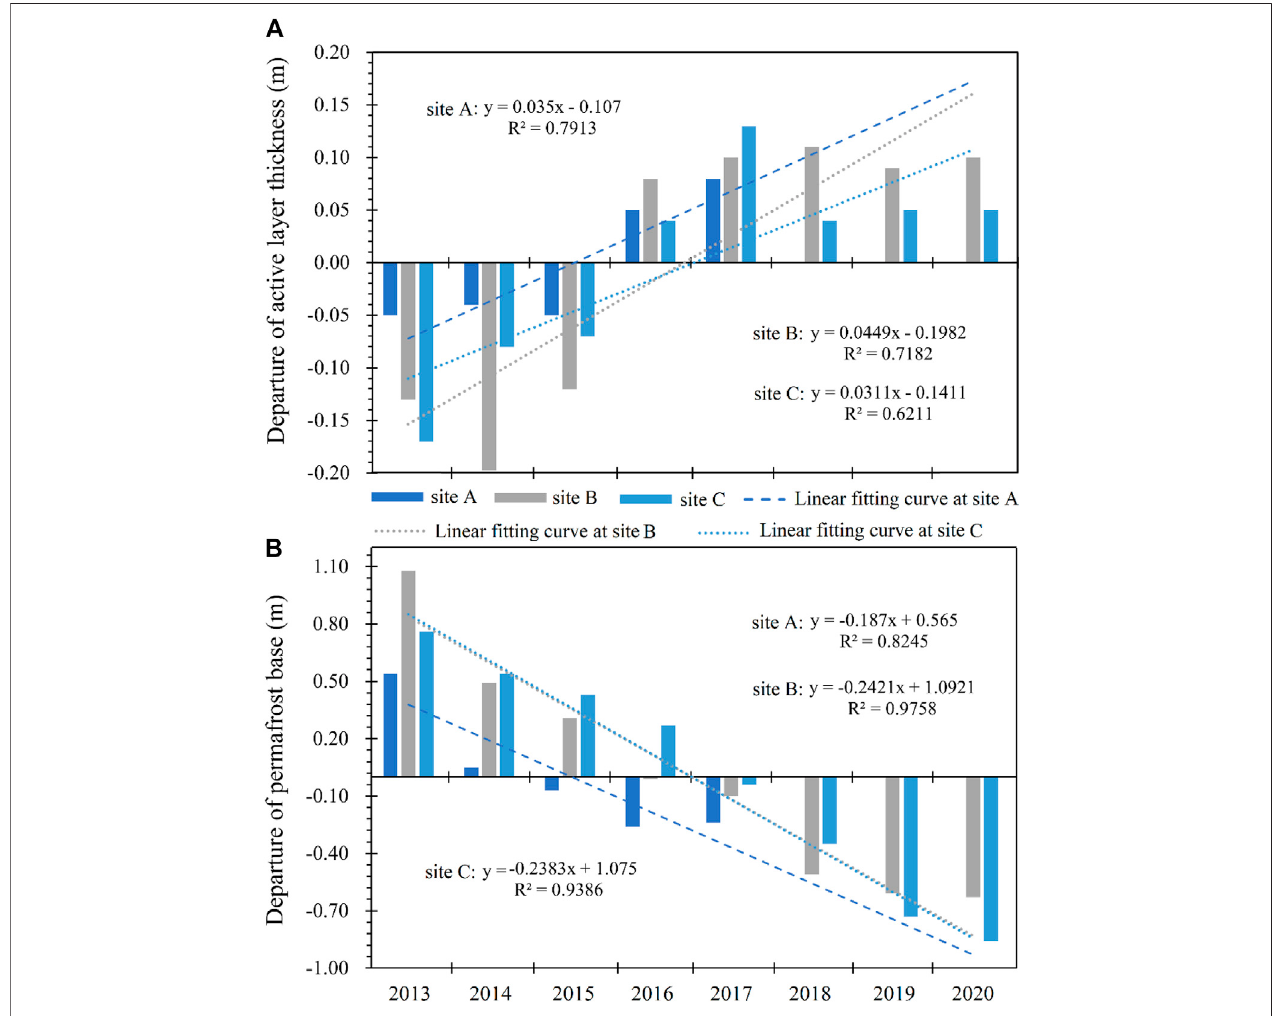
FIGURE7| Changesinthethicknessoftheactivelayer (A) andthedepthofthepermafrostbase (B) atthethreesites(SiteA,SiteB,andSiteC)from2013to2020. The linear regression coef fi cients and coef fi cient of determination ( R 2 ) are shown in fi gure.